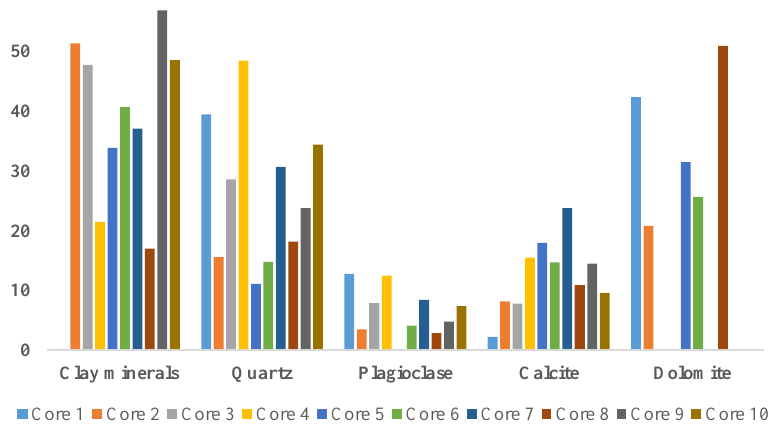
Figure 1. Mineral composition of shale in the Nanpu block.